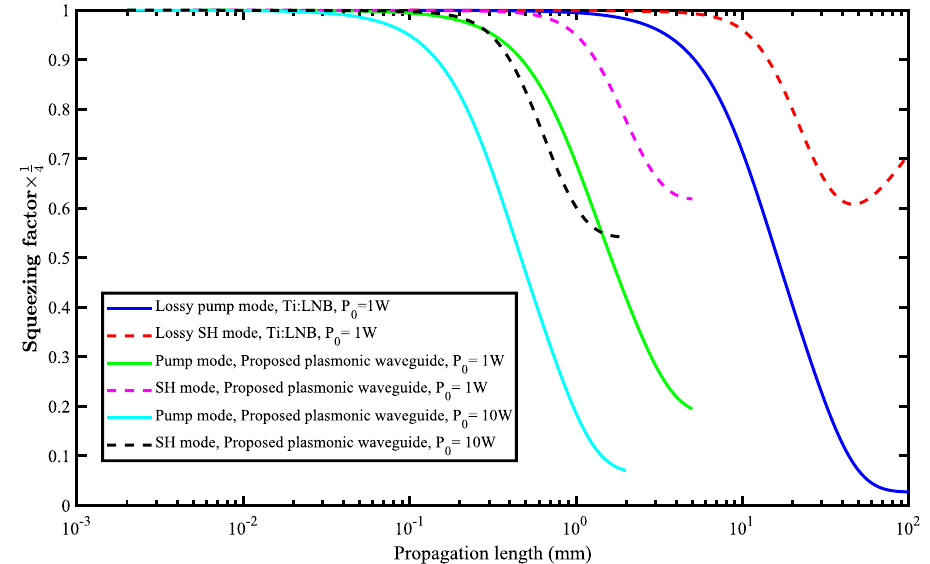
Figure 8. Squeezing of the pump mode (blue-solid line) and SH mode (red-dashed line) in the traditional Ti:LNB waveguide ( P 0 = 1 W ). Squeezing of the pump mode (green-solid line) and the SH mode (magenta- dashed line) in the proposed plasmonic waveguide for P 0 = 1 W . Squeezing of the pump mode (cyan-solid line) and the SH mode (black-dashed line) in the proposed plasmonic waveguide for P 0 = 10 W . The log-scale is used for the horizontal